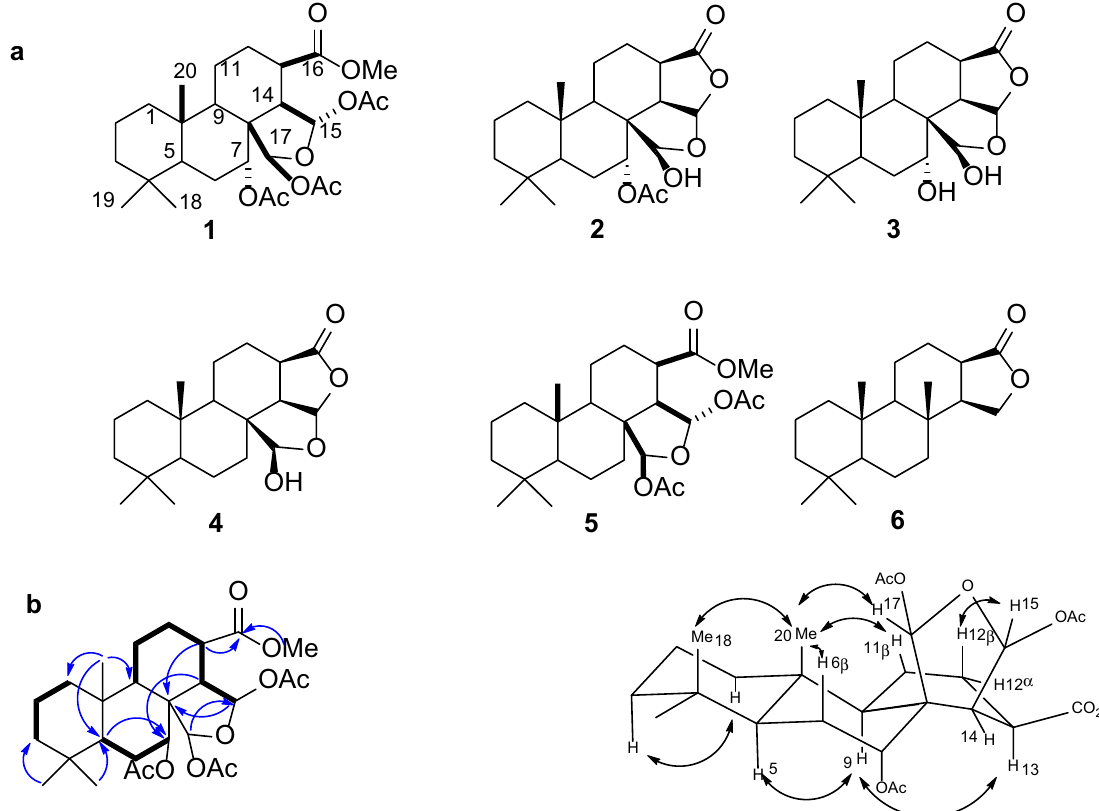
Figure 1. Diterpenes from marine sponge Spongionella sp. ( a ), The structures of compounds 1 – 6 . ( b ), Key COSY ( ), HMBC ( ) and NOESY ( ) correlations for the new compound